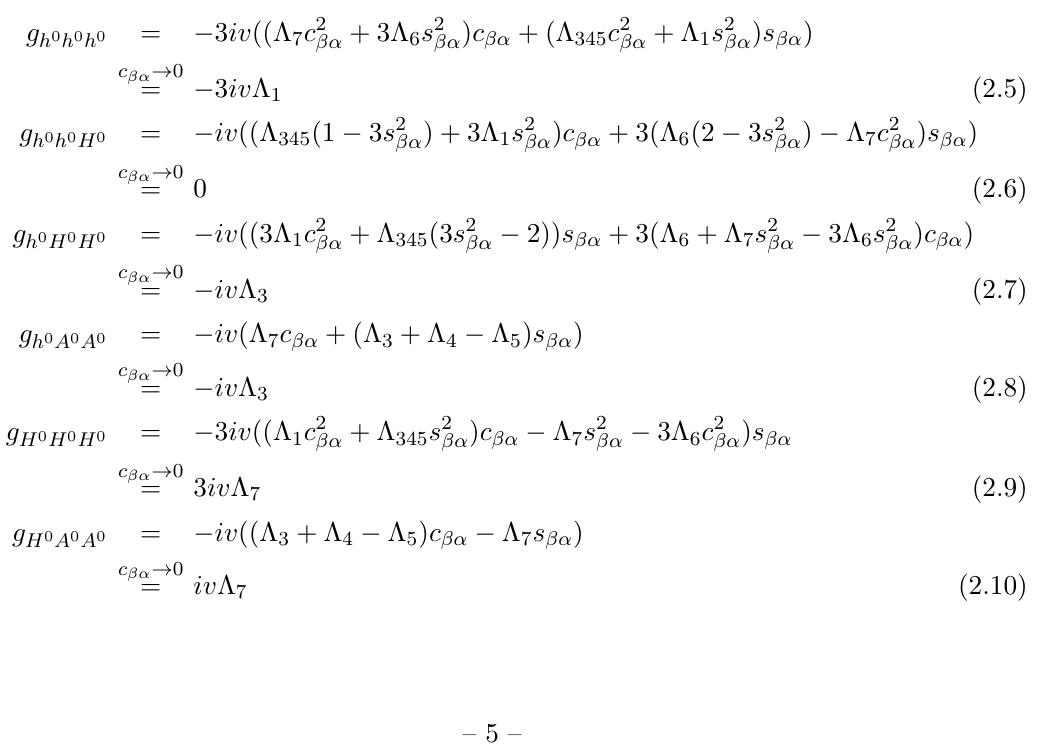
versus t (cid:12) 3